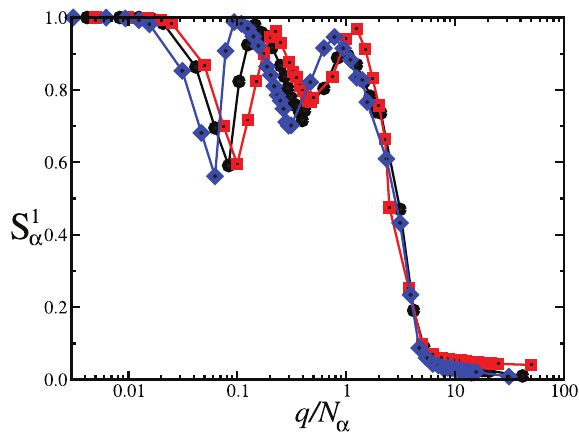
as a function of a